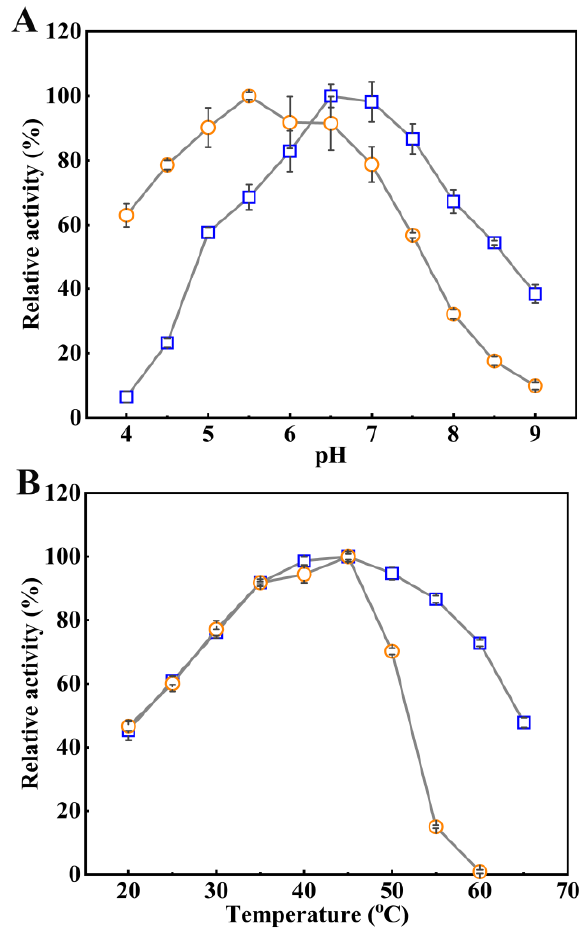
Figure 4. Effects of pH and temperature on enzymatic activities of arylesterase LggEst wild type and the deleted mutant. ( A ). Effects of pH on enzymatic activities of LggEst wild type and the deleted mutant at 45 °C under pH 4 – 9. Enzymatic activities of wild type and the deleted mutant are normalized as percentages of maximum activity in pH 6.5 and pH 5.5, respectively. ( B ) Effects of temperature on enzymatic activities of LggEst wild type and the deleted mutant in 50 mM NaH 2 PO 4 -Na 2 HPO 4 buffer (pH 7.5) at 20 – 65 °C. Enzymatic activities are normalized as percentages of maximum activity at 45 °C. The data for wild type and the deleted mutant are shown in blue square and orange circle, respectively. All reactions were performed in triplicate, and error bars represent the standard deviations of mean.